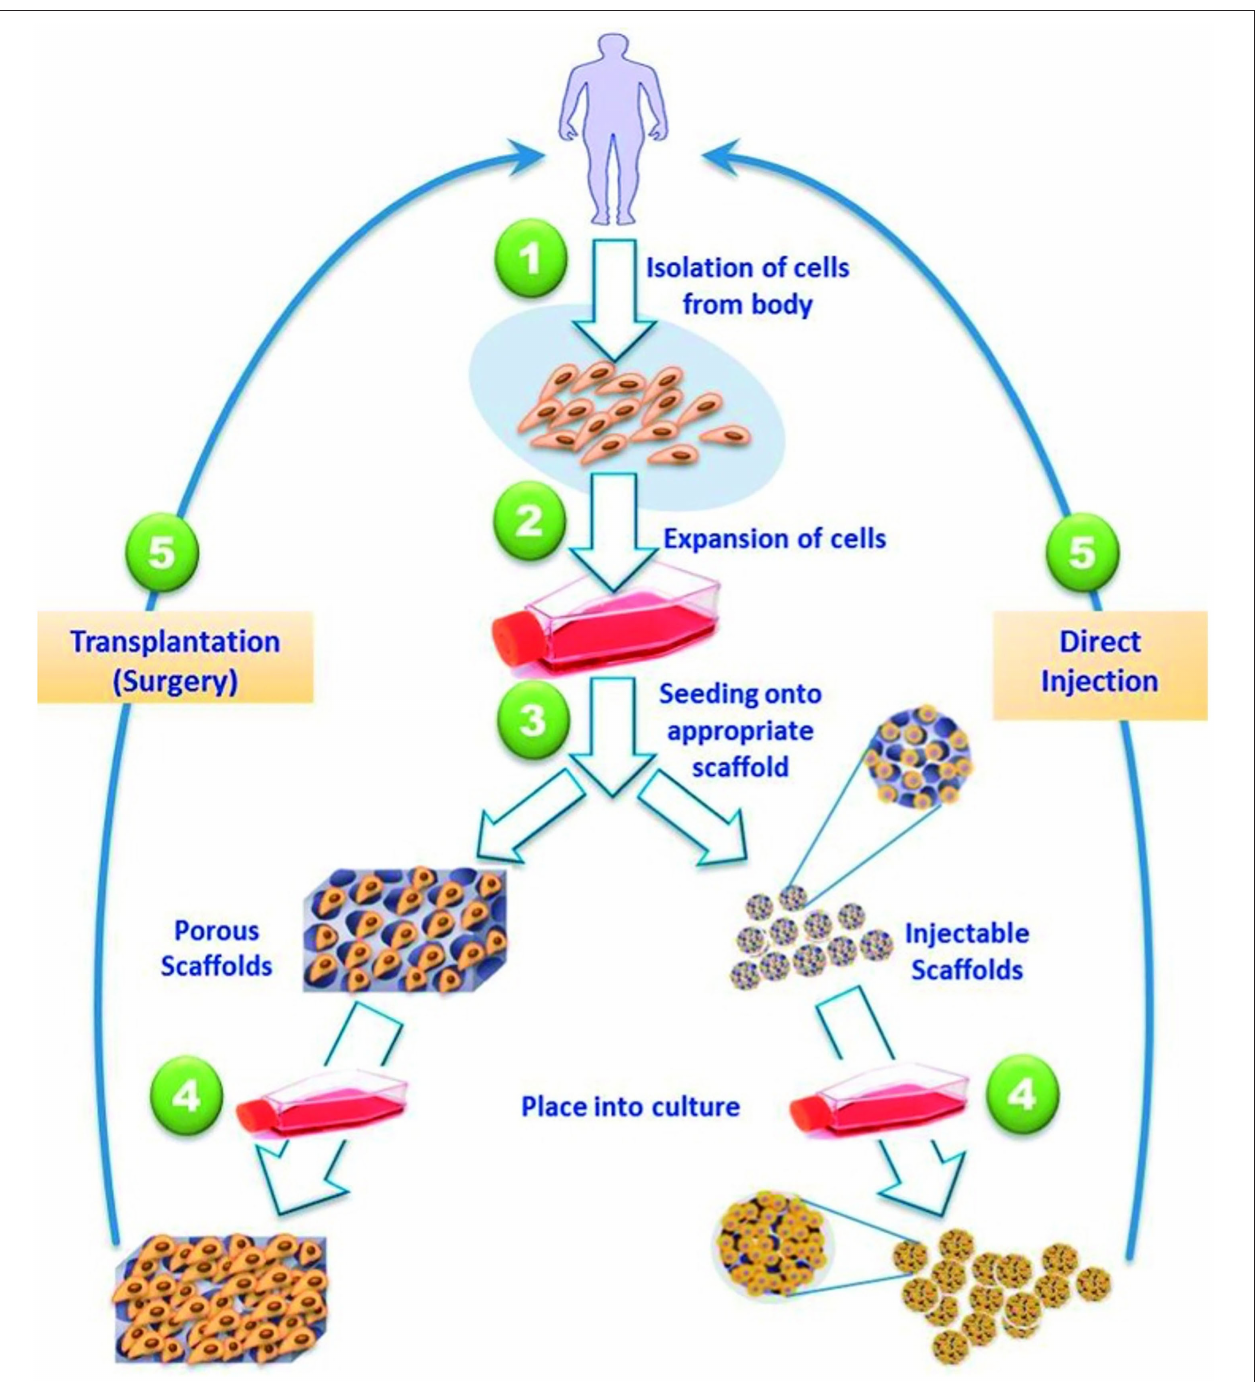
FIGURE 6 | Strategies for tissue engineered cardiac replacement parts delivered either via surgical or percutaneous implantation. Reprinted from El-Sherbiny et al.